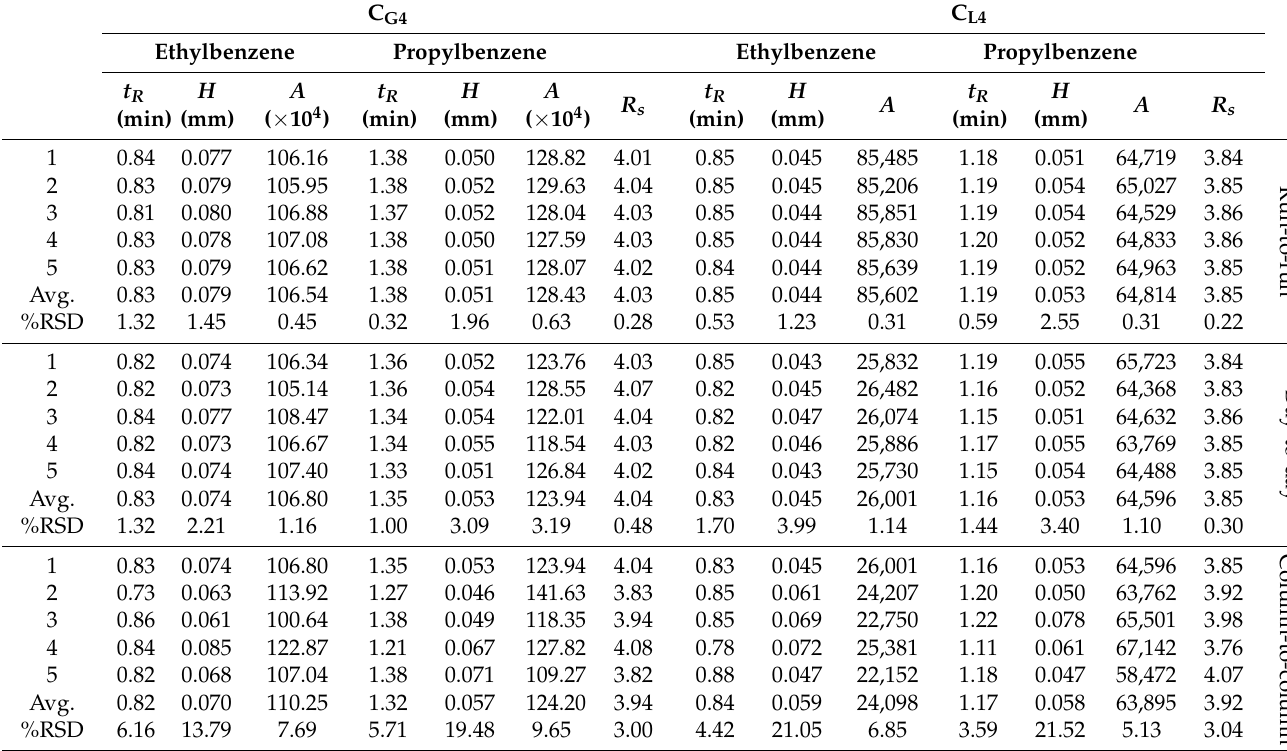
Table 3. Repeatability and reproducibility study of the C G4 and C L4 columns expressed as %RSD under the optimal conditions in terms of the t R , H , A , and R s